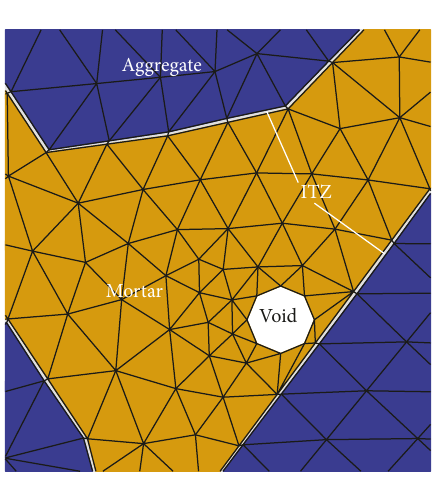
Figure 3: FE mesh discretization after inserting and adjusting.